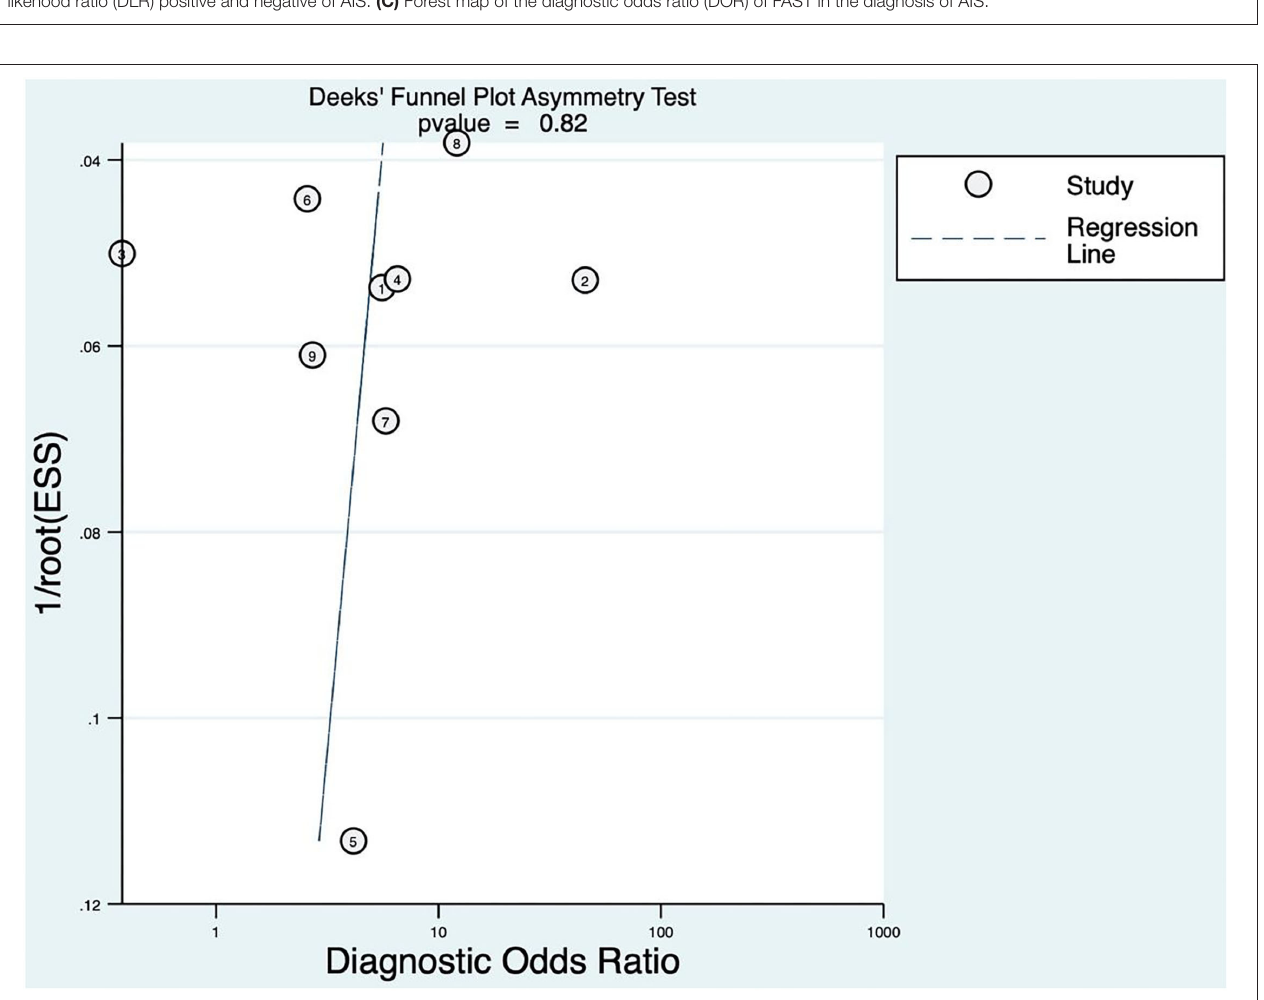
FIGURE 3 | Deeks’ funnel plot asymmetry test for